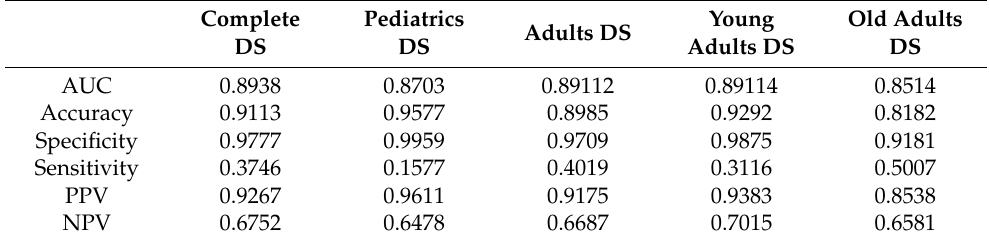
Table 3. Summary of models’ performance